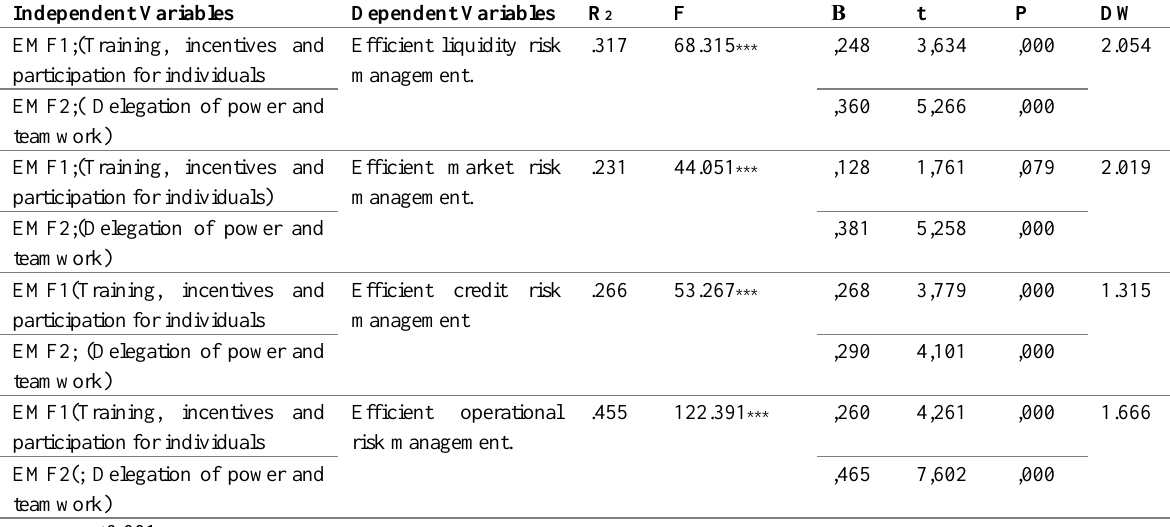
Table 7: Summaries of regression